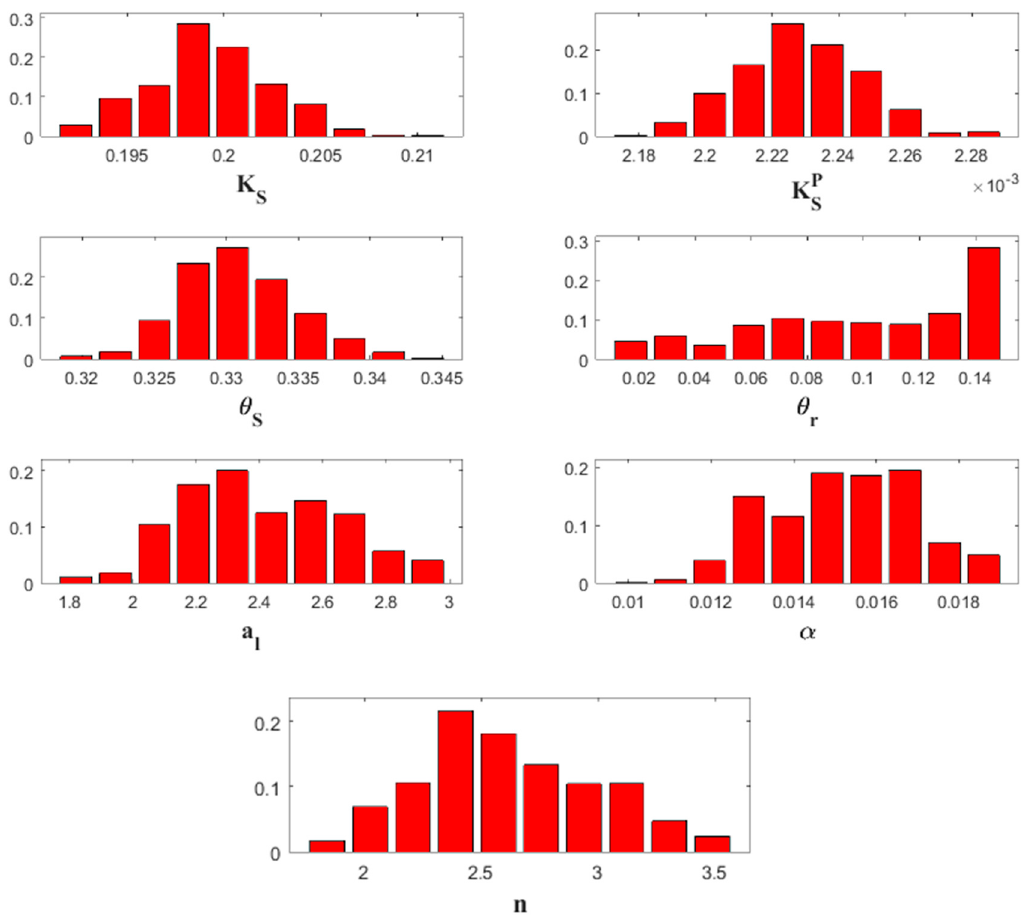
Figure 5. Histograms of marginal distribution of parameters with the linear transport model.